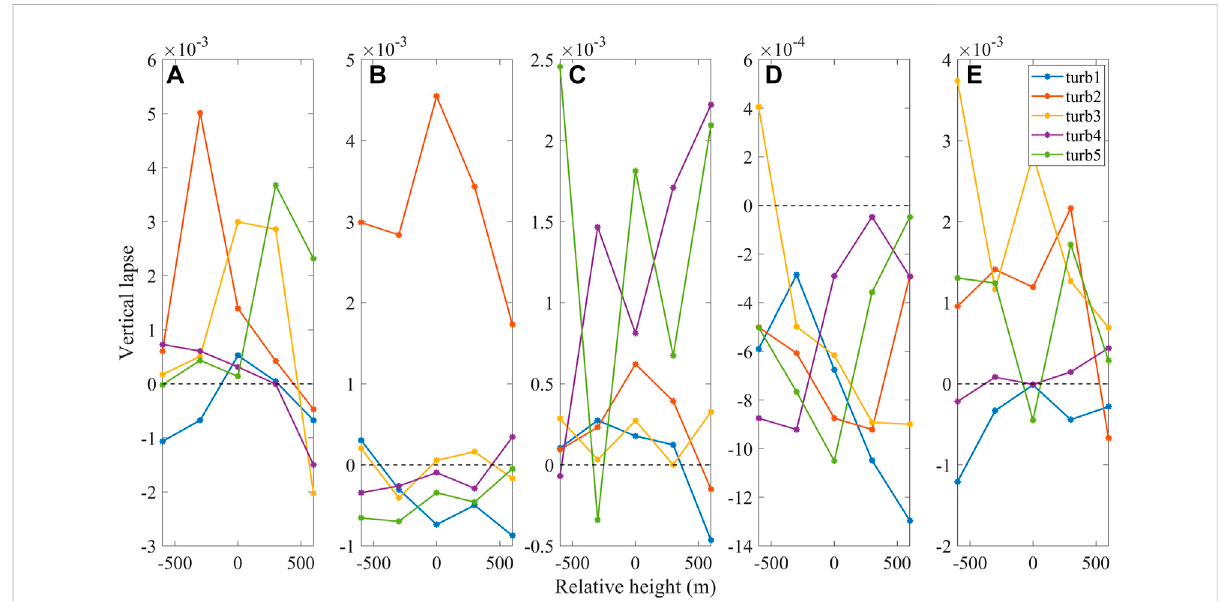
FIGURE 7 Distributions of the ozone gradient above and below 750 m near the 5 regions of largest turbulence: panels ( A – E ) represent the data collected from October 15 to 21,